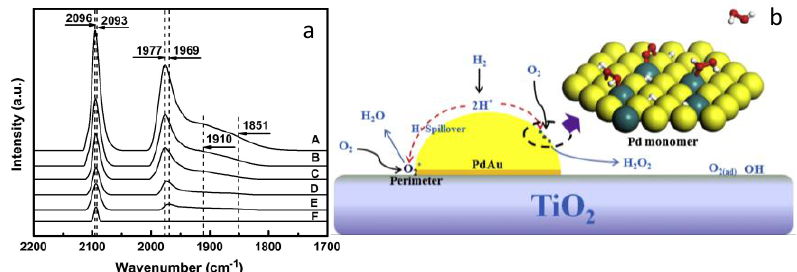
Figure 9 . ( a ) In situ DRIFTS of CO adsorption over different catalysts at room temperature in streams of Ar with a flow rate of 50 ml/min. A: Pd, B: Pd2.5Au0.5, C: Pd2.0Au1.0, D: Pd1.5Au1.5, E: Pd1.0Au2.0, F: Pd0.5Au2.5. ( b ) Mechanism of H 2 O 2 synthesis directly from H 2 and O 2 on a Pd monomer catalyst. Reprinted from J. Catal., 311, L. Ouyang, G. Da, P. Tian, T. Chen, G. Liang, J. Xu, Y.-F. Han, Insight into active sites of Pd–Au/TiO 2 catalysts in hydrogen peroxide synthesis directly from H 2 and O 2 , 129–136, Copyright (2014), with permission from